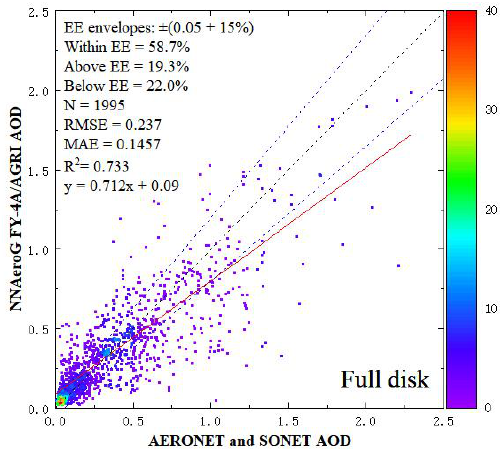
Figure 4. Scatterplots of FY-4A/AGRI retrieved full disk AOD versus AERONET and SONET reference data. The blue lines are the EE envelopes for AOD of ± (0.05 + 15%). The red line is the linear fitting line of AOD. The black line represents the 1:1